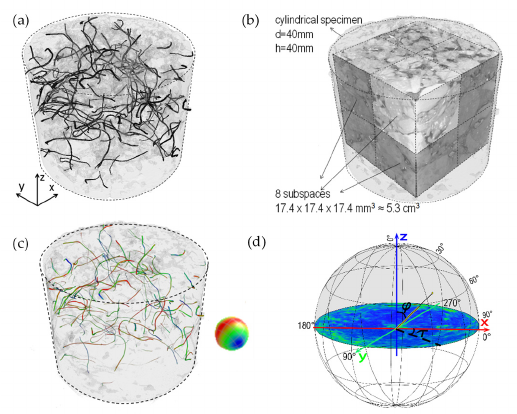
Figure 3. ( a ) Aspect of the specimen with 1.5% of fibers. ( b ) View of the subspaces used for the distribution analysis. ( c ) Space orientation of the fibers, according to the color mapping shown in the sphere. ( d ) Schematic of the construction of a polar plot for fiber orientation analysis.